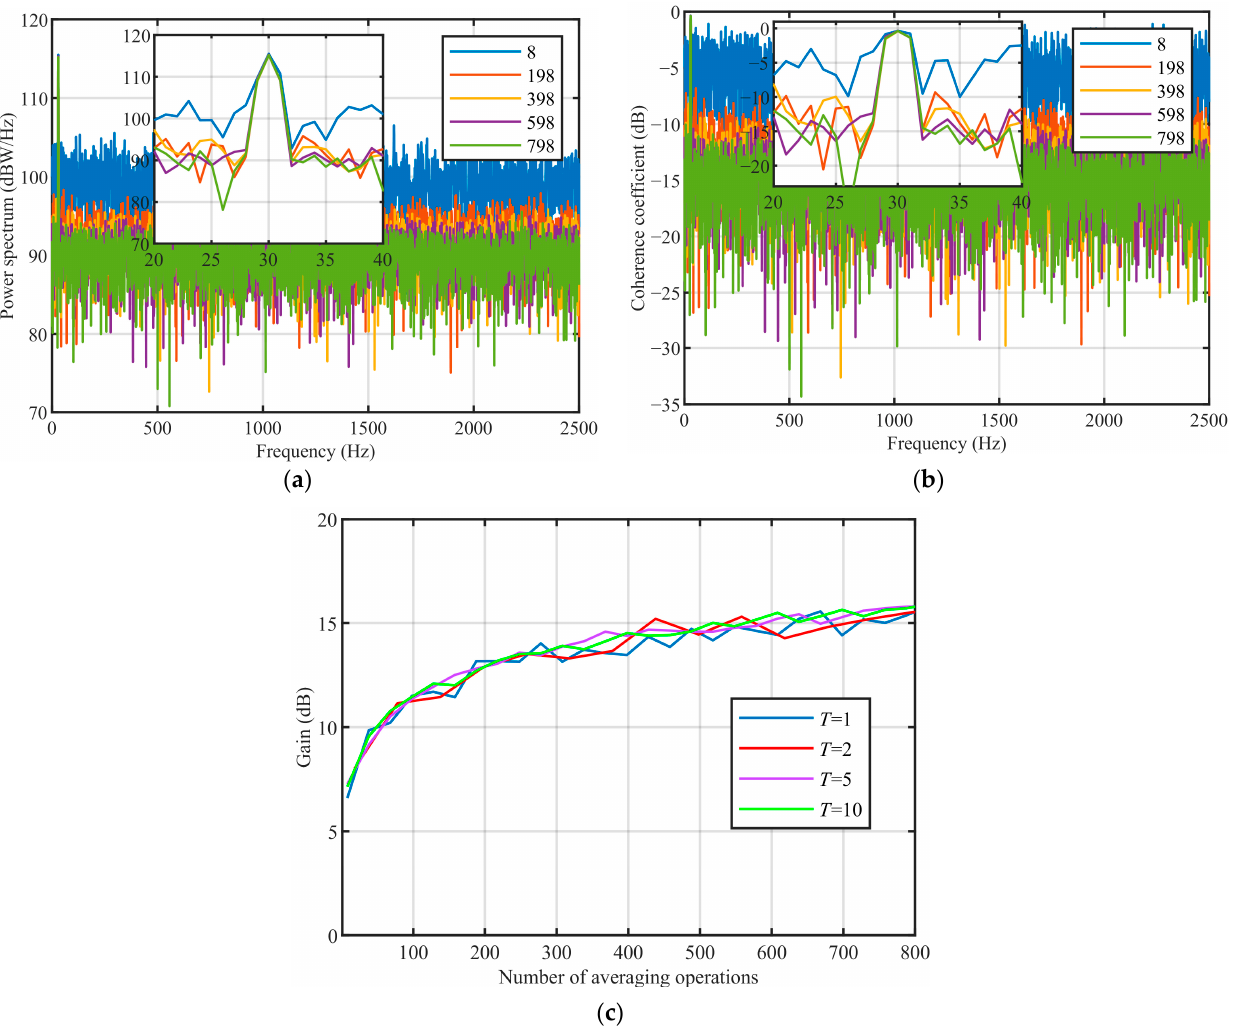
Figure 4. SHCS processing results with different numbers of averaging operations: ( a ) power ‐ spectrum estimation with T = 1 s; ( b ) coherence ‐ coefficient calculation with T = 1 s; ( c ) gain.